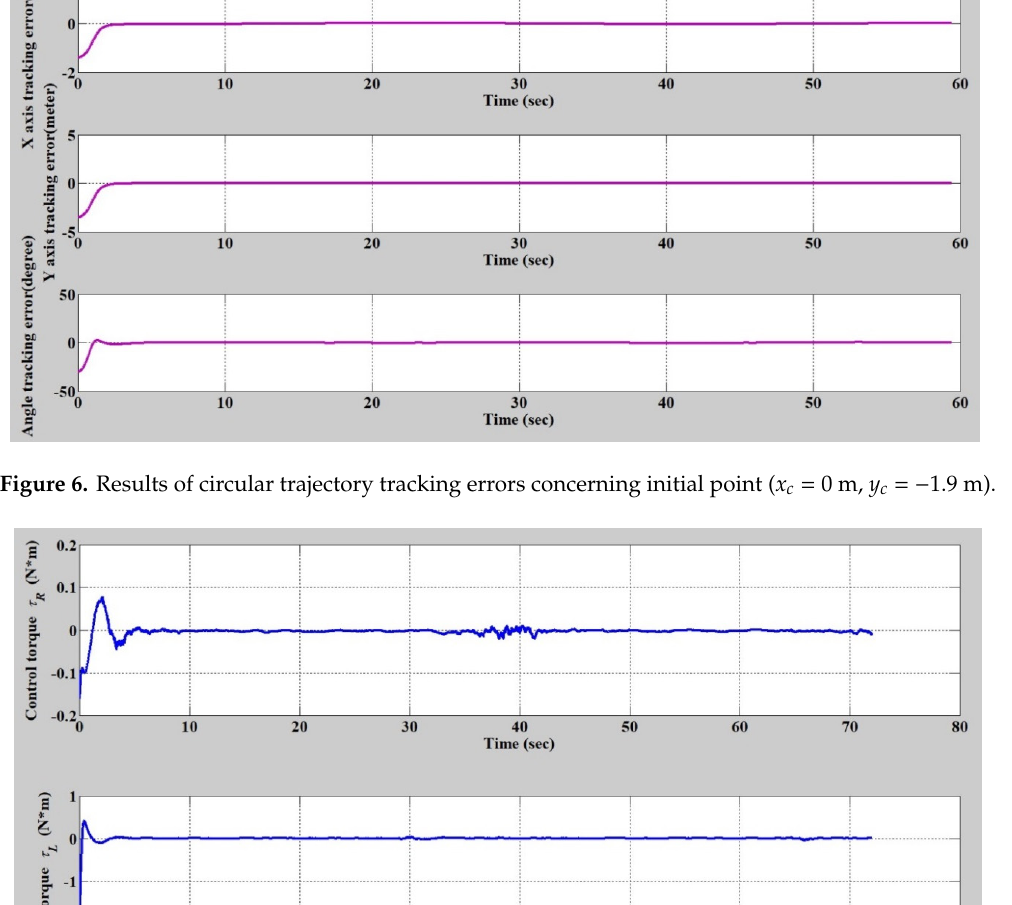
Figure 7. Results of circular trajectory tracking torques concerning initial point ( x c = 1.9 m, y c = 0 m).